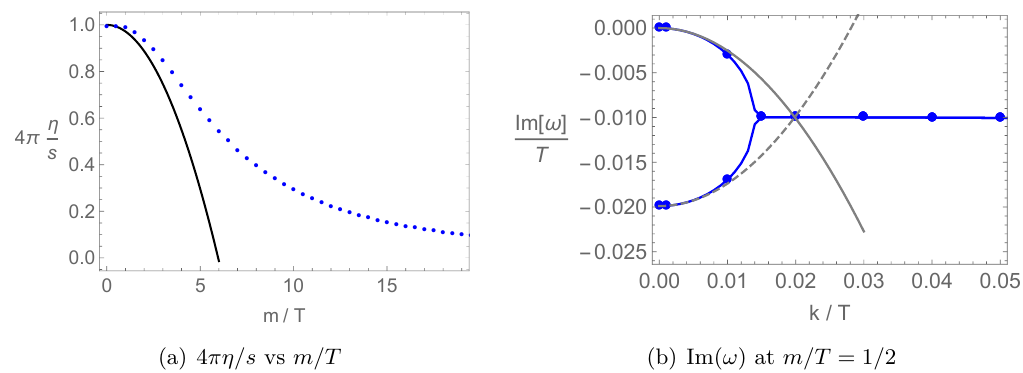
Figure 2 . Left: the violation of KSS bound with axion charge. Blue dots are numerical results, and the black solid line is the analytic result of (3.20). Right: quasi-normal modes vs hydrodynamic predictions. Blue dots are numerically computed quasi-normal modes, the blue solid line is (3.14), the gray solid line is (3.17), and the gray dashed line is